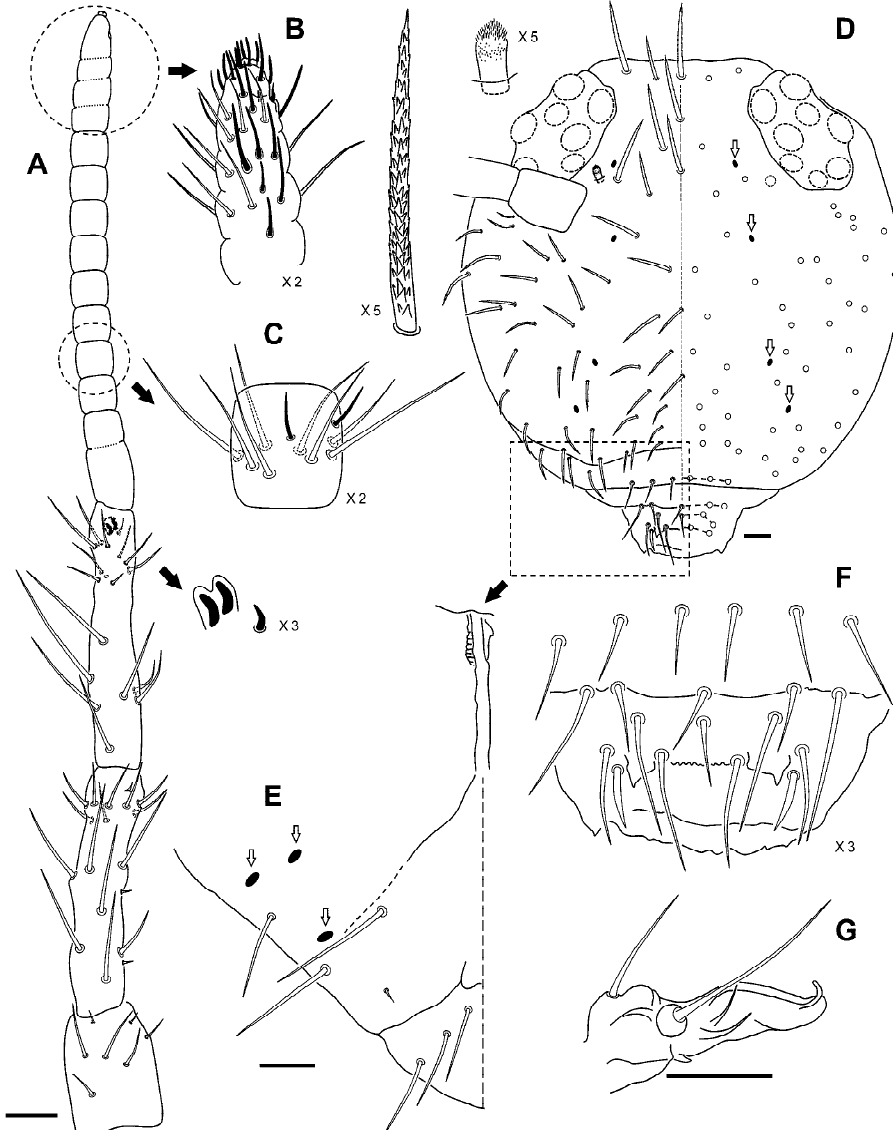
Figure 7. Allacma cryptica Baquero and Jordana sp. nov.: ( A ) antenna; ( B ) detail of the antennal tip; ( C ) detail of one of the Ant IV medial sub-segments (the remaining are similar); ( D ) head, dorsal view, with detail of one of the Mc from vertex and post-antennal special chaetae (oval organs pointed with white arrows); ( E ) head, partial ventral view to show the disposition of the three oval organs (white arrows); ( F ) labrum; ( G ) maxillary palp and sublobal plate (scale bars: all 0.05 mm). Body. Bothriotricha insertion linear or with a slightly obtuse open forward angle; 60 bothriotrichum D inserted on small abdomen. Trochanter with a posterior spine-like 61 Diagnosis chaeta. Claws broad, with tunica and serrated pseudonychia ; inner tooth present on all 62 Post-antennal chaeta long and slightly pointed, the sculpture of head vertex Mc scale- legs; empodium of all legs without an internal tooth, pointed and acuminated, and with a 63 like and pointed, Ant II and III with 6–5 long chaetae each, 13–15 sub-segments on Ant IV, filament not reaching the tip of claw on legs I–II, surpassing the claw on leg III; pretarsus 64 two unpaired clypeal chaetae, a conspicuous tooth on the ventral claw, tunica and with two chaetae (Figures 8A–B). Body with nearly smooth but broad chaetae. Tenacu- 65 lum with two chaetae on the corpus. Manubrium with six dorsal chaetae, in three rows: 66 three distal, two medial, and one proximal. Dens anterior with 3, 2, 2, 2, 1…1 chaetae (the 67 Holotype, asymmetrically, has 3, 2, 2, 2, 2…1); posterior chaetae of normal length, with 68